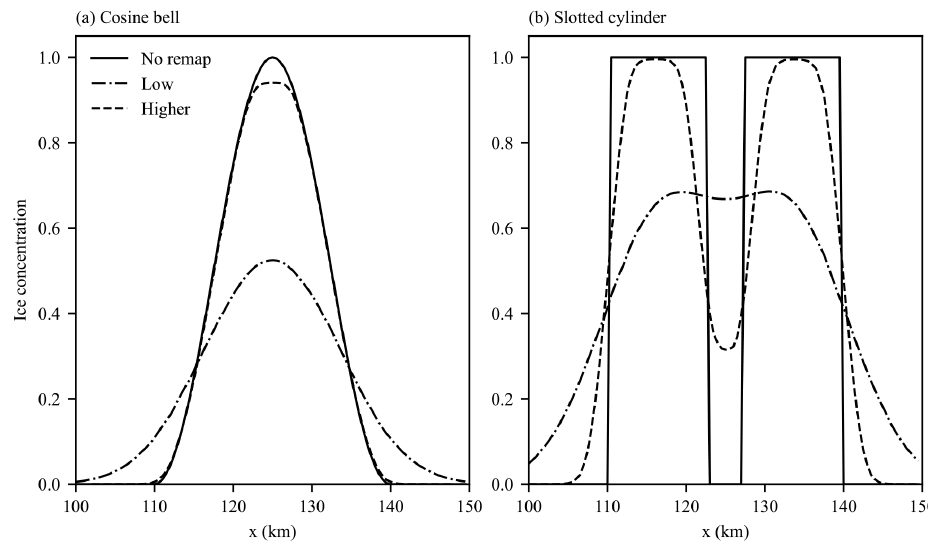
Figure 6. Cross section ( y = 50km) of ice concentration for the two-dimensional test case for the initial (a) cosine bell and (b) slotted cylinder particle distributions. Results for no remapping, low-order remapping, and higher-order remapping are